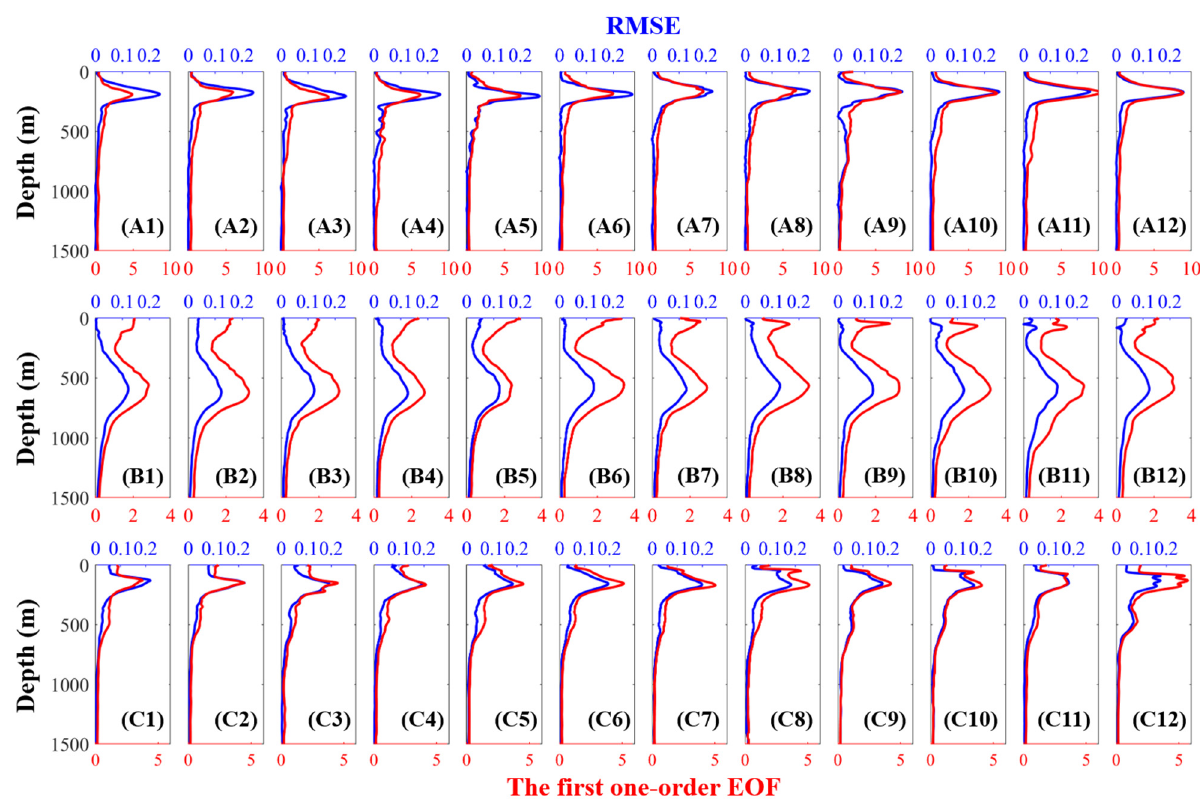
Figure 7. The vertical structure of the first one-order EOF and RMSE depth of SSP in Areas A ( A1 – A12 ), B ( B1 – B12 ), and C ( C1 – C12 ) with the blue and red lines representing the first one-order EOF and RMSE depth of the SSP.